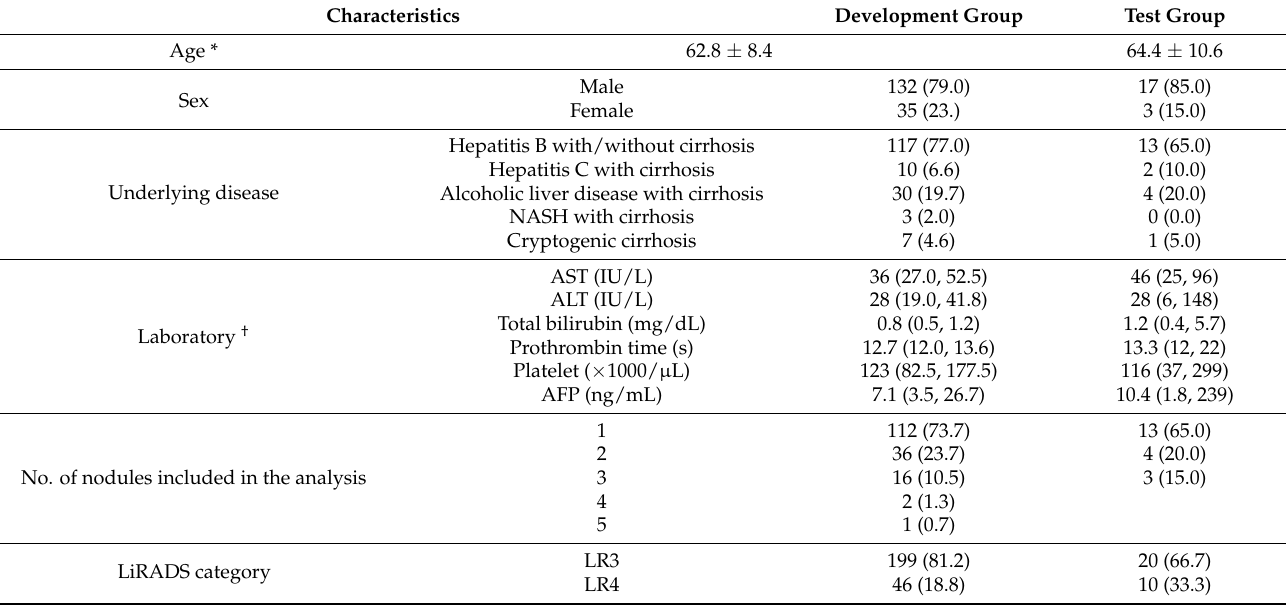
Table 1. Baseline characteristic of 245 observations in 167-patient development group and 30 observa- tions in 20-patient test